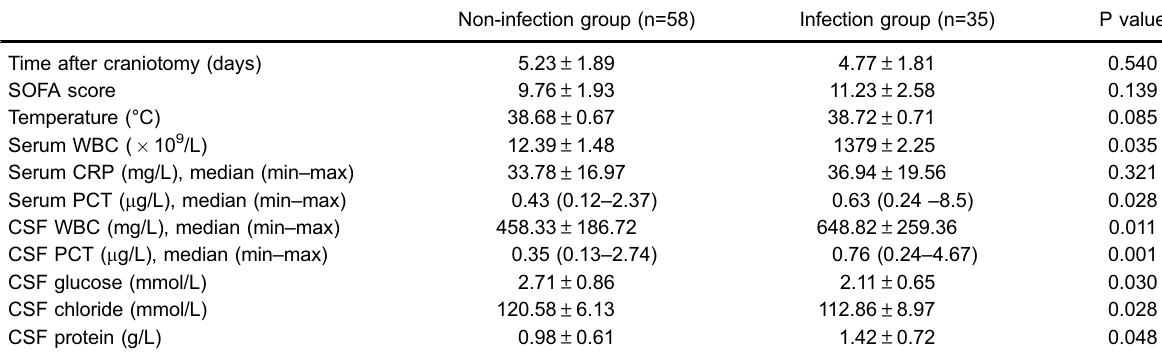
Table 3. Comparison of clinical data between infection group and non-infection group at day 1.